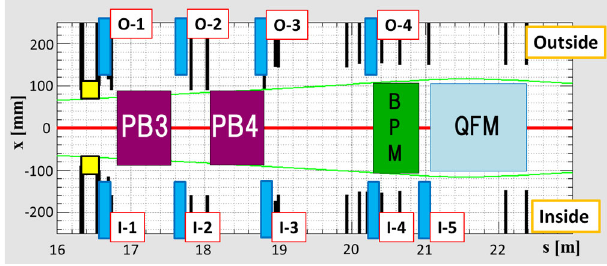
FIG. 9. Arrangement of the